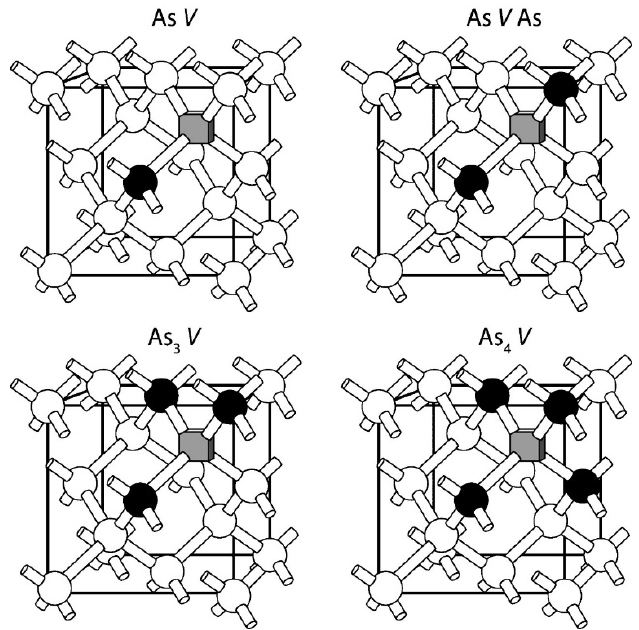
Figure 3. A schematic representation of the As n V clusters (n = 1–4). Cubes represent the vacancies, and white and black circles represent the Ge and As atoms, respectively [35].